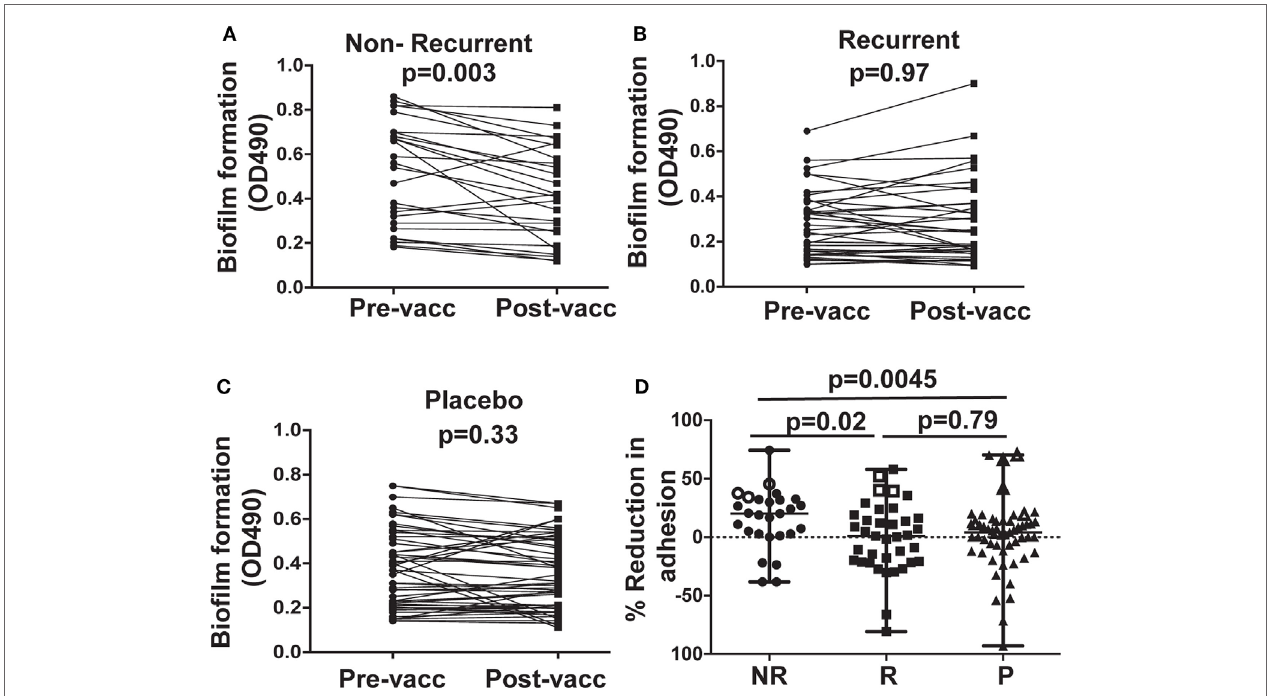
FigUre 3 | In vitro assessment of Candida albicans biofilm formation in presence of patient sera. Post-vaccination sera from 27 non-recurrent (NR) patients significantly ( p = 0.003) reduced C. albicans biofilm formation on 96-well microtiter plates, when compared to their respective pre-vaccination sera (a) . There was no difference in the extent of biofilm growth between pre- and post-vaccination sera from 37 recurrent (R) patients ( p = 0.97) (B) , or 53 placebo (P) patients ( p = 0.33) (c) . The percent inhibition of C. albicans biofilms to plastic was significantly higher in post-vaccination sera of NR patients vs. that from R or P patients (D) . Data in (D) are presented as median ± interquartile range. Each dot represents alteration in C. albicans biofilm formation due to an individual patient sample. The open data points in (D) represent six placebo and six NDV3-A vaccinated patients (three R and three NR) whose sera showed the highest reduction in biofilm formation and were chosen for the vaginal epithelial cell invasion assay presented in (B)